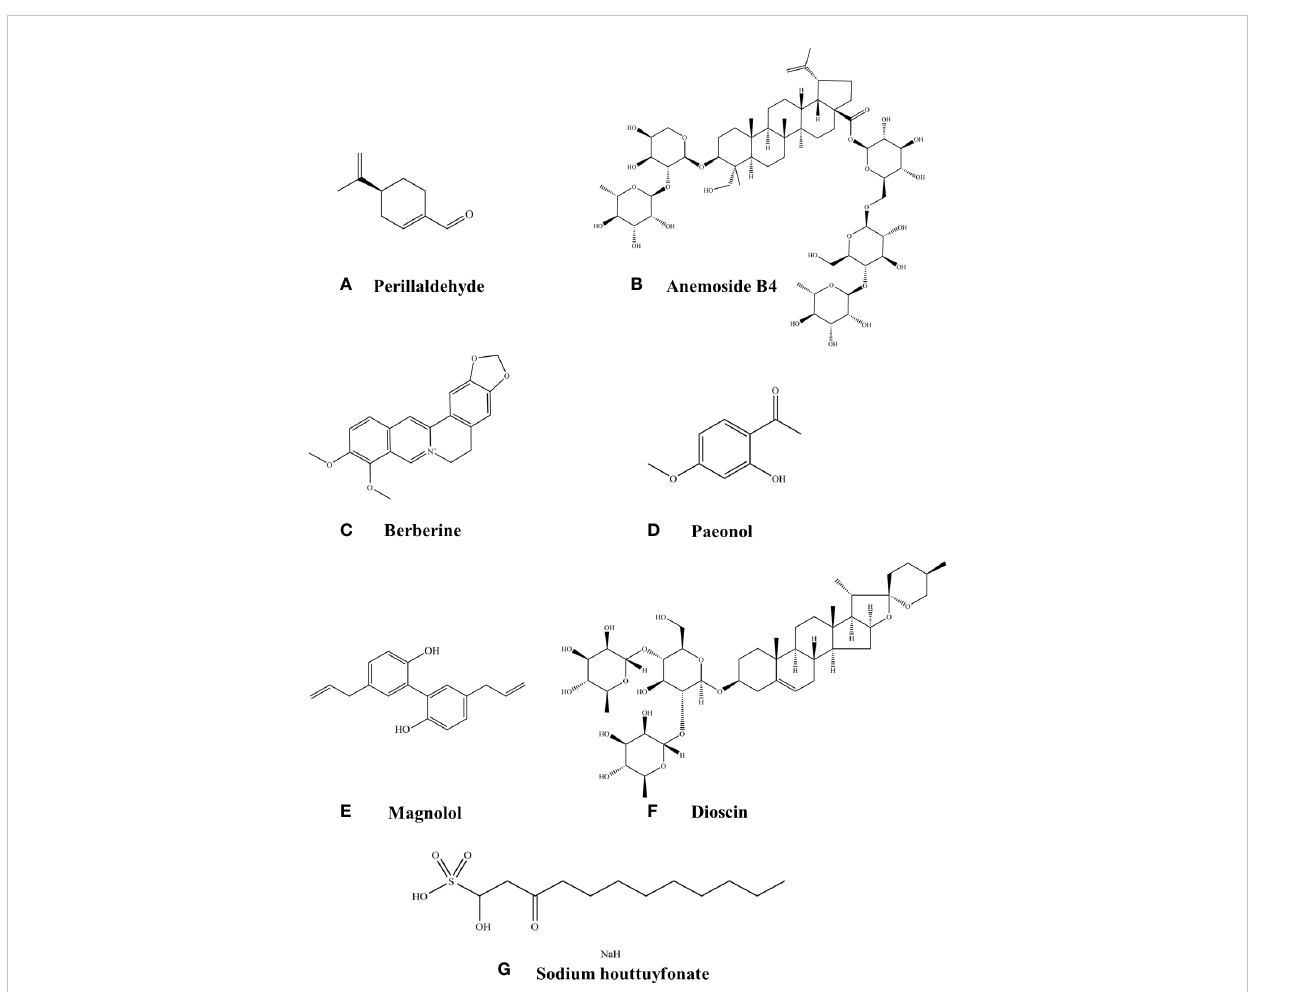
FIGURE 2 Chemical structures of the listed compounds. (A) Perillaldehyde. (B) Anemoside B4. (C) Berberine. (D) Paeonol. (E) Magnolol. (F) Dioscin. (G) Sodium